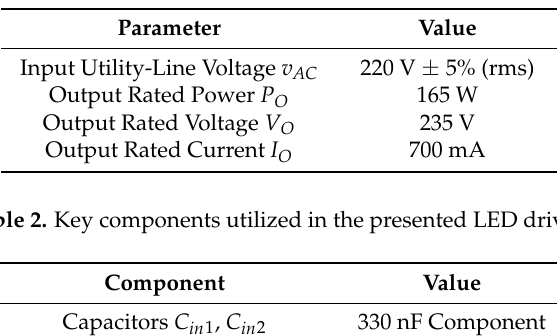
Table 1. Specifications of the presented single-stage LED driver.